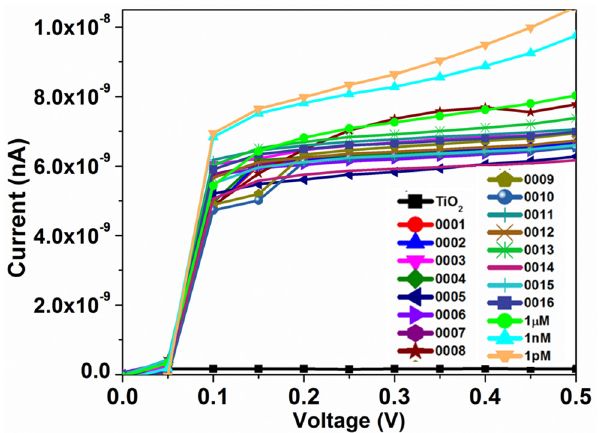
Fig 7. Current responses of different target DNA hybridized on the 10 μ M probe DNA. The target DNA was from the lysed E . coli O157:H7. Different concentrations of target DNA were